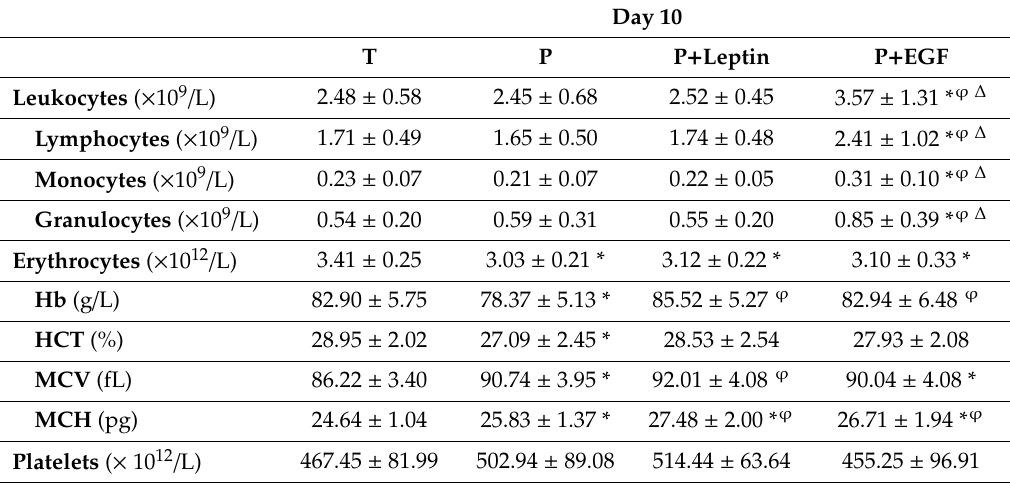
Table 2. Blood cell count from the four groups: Term (T), Preterm (P), P + Leptin, and P + epidermal growth factor (P + EGF) at day 10 of the suckling